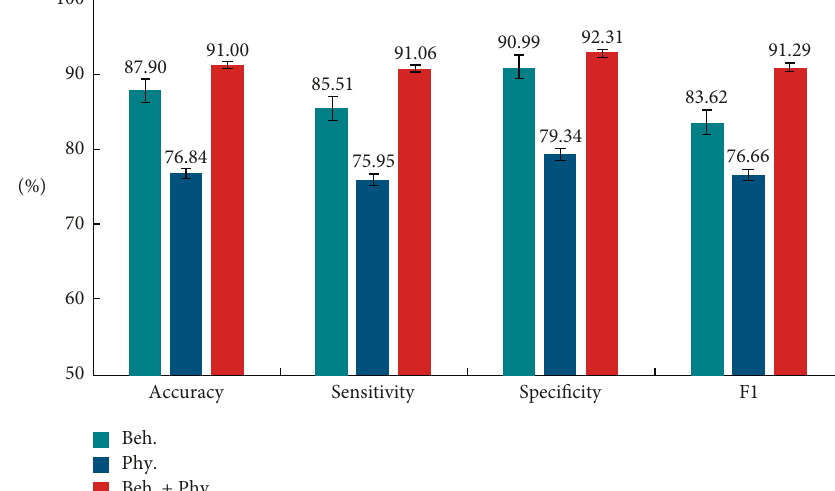
Figure 7: Classification results for different signal features. Beh. represents the eye movement behavioral signals; Phy. represents the eye movement physiological signals; Beh.+ Phy. represents the fusion features of eye movement behavioral and physiological